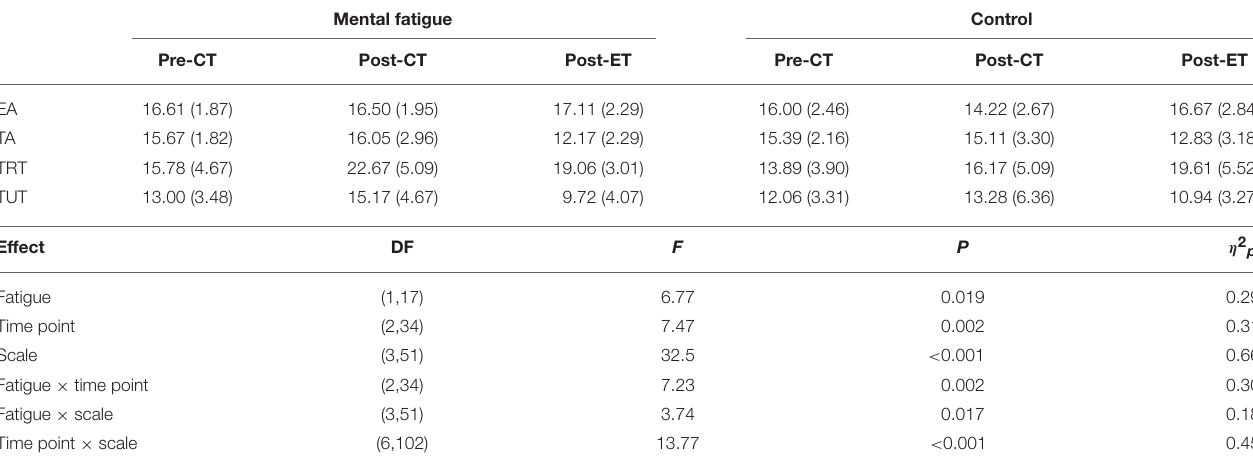
TABLE 3 | Descriptive statistics (M, SD ) and significance test for the DSSQ scales and